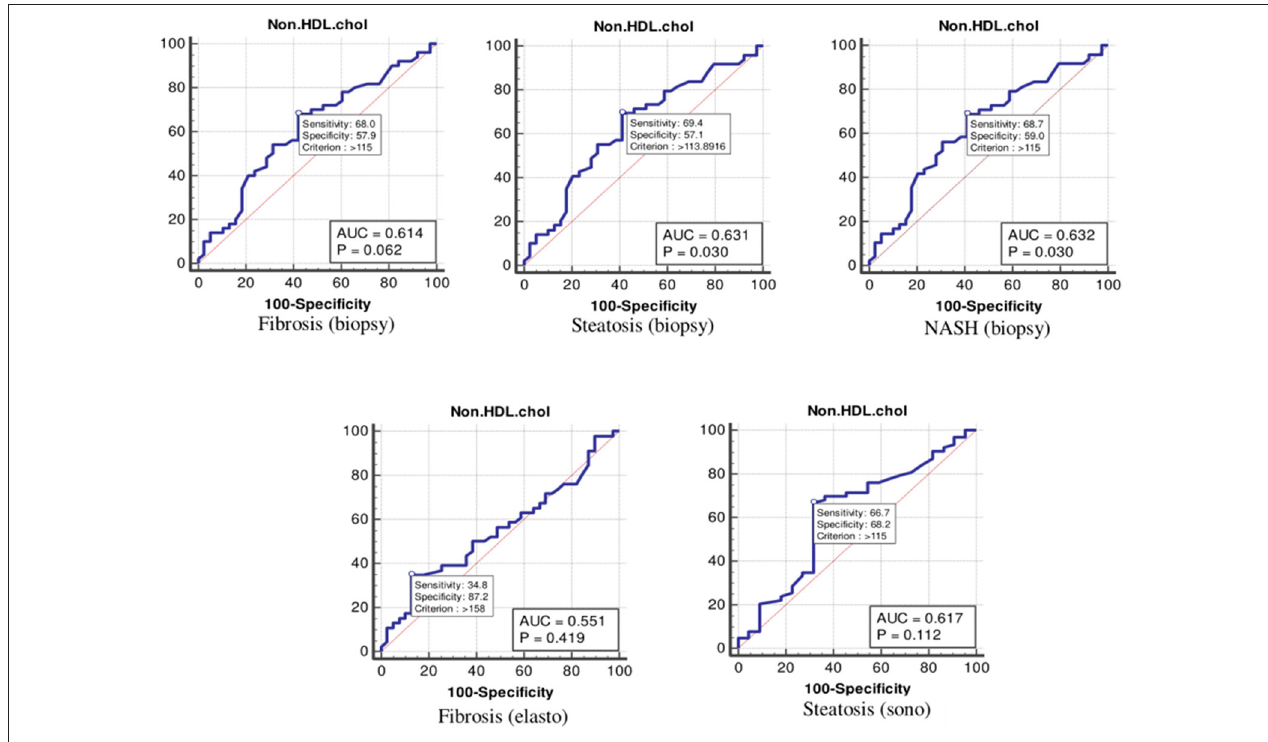
FIGURE 3 | The receiver operating characteristics curve for non-high-density lipoprotein cholesterol in the detection of liver disease.